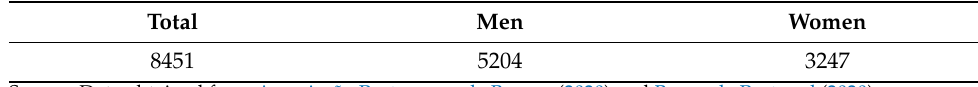
Table 4. HR by leadership